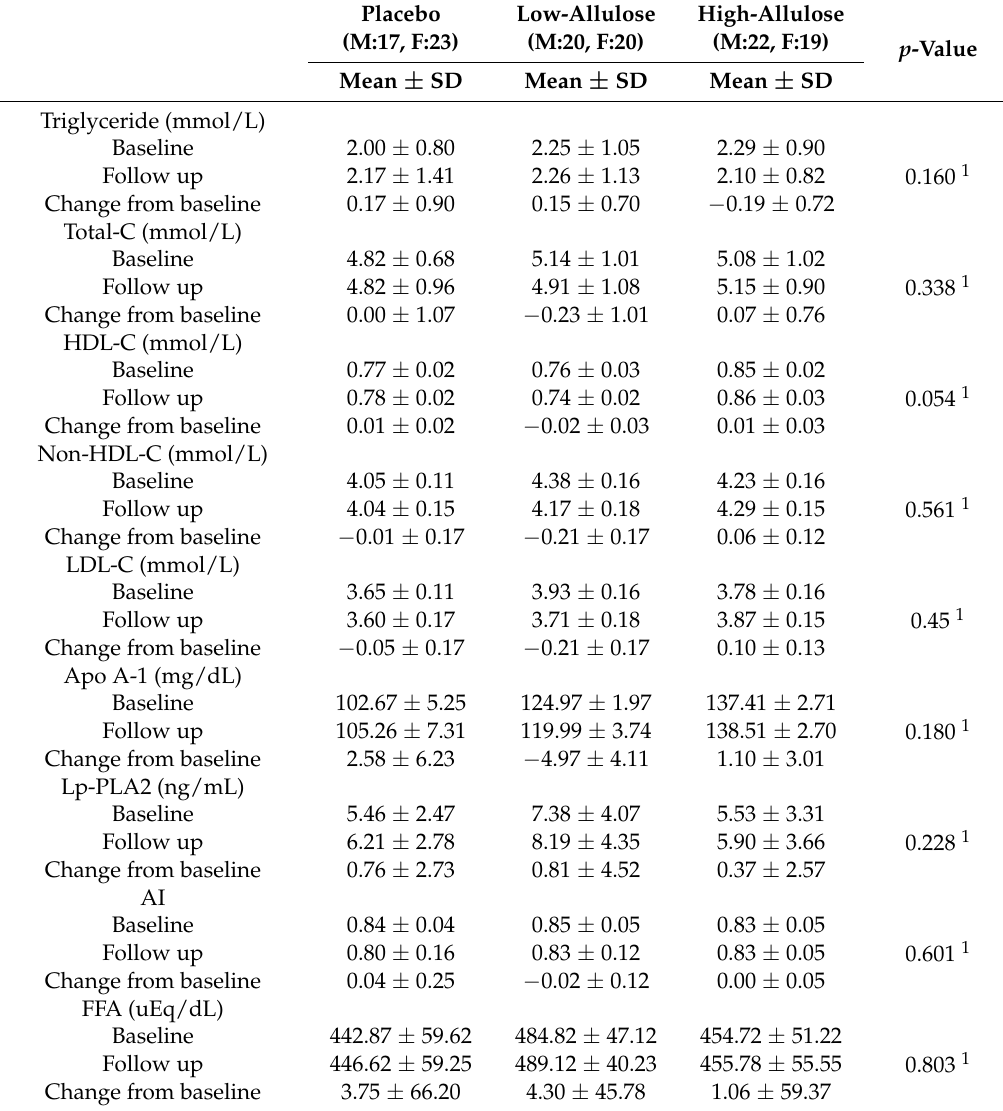
Table 6. Dose-dependent effect of D -allulose supplementation for 12 weeks on lipid profiles in overweight and obese